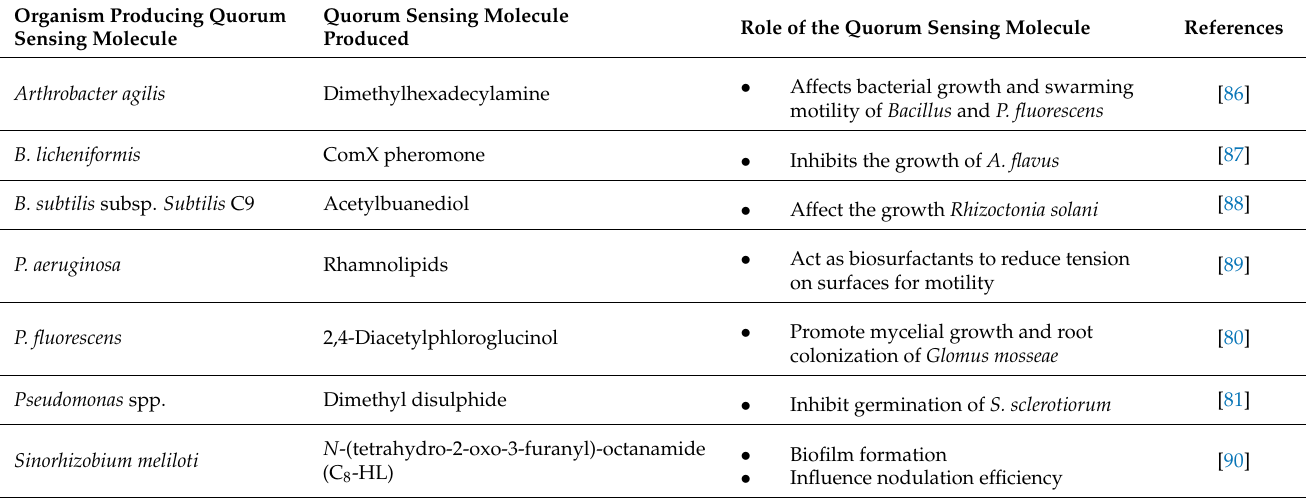
Table 2. Quorum Sensing Molecules Produced by Rhizospheric